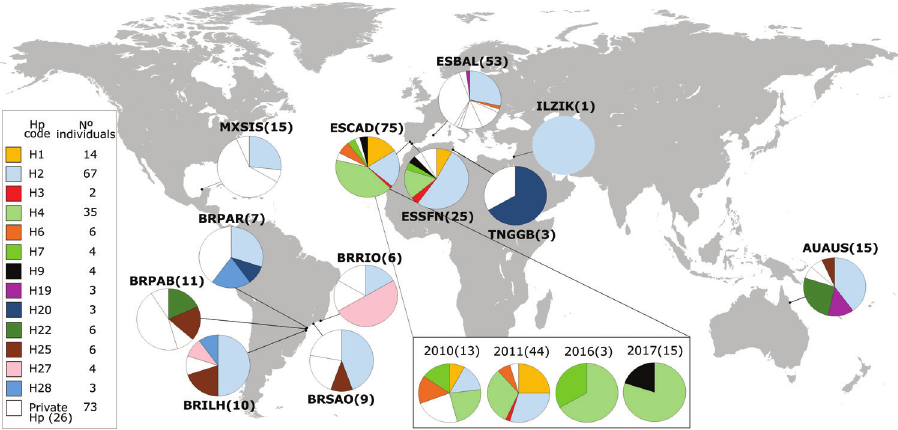
Figure 2. Geographical distribution of the 39 mtDNA haplotypes (Hp) of Paracaprella pusilla in the populations sampled. Each site is represented by a pie chart showing population composition and relative haplotype frequency. Number of analysed individuals per population appears in brackets. White-shaded areas are the cumulative proportion of private haplotypes per location. Sites are coded as in Tables 1 and 2. The legend gives information about the existing haplotypes across all locations and the number of in- dividuals carrying each haplotype. For the Cadiz marina (ESCAD) population, the change in haplotype frequency is shown in the four years when the species was